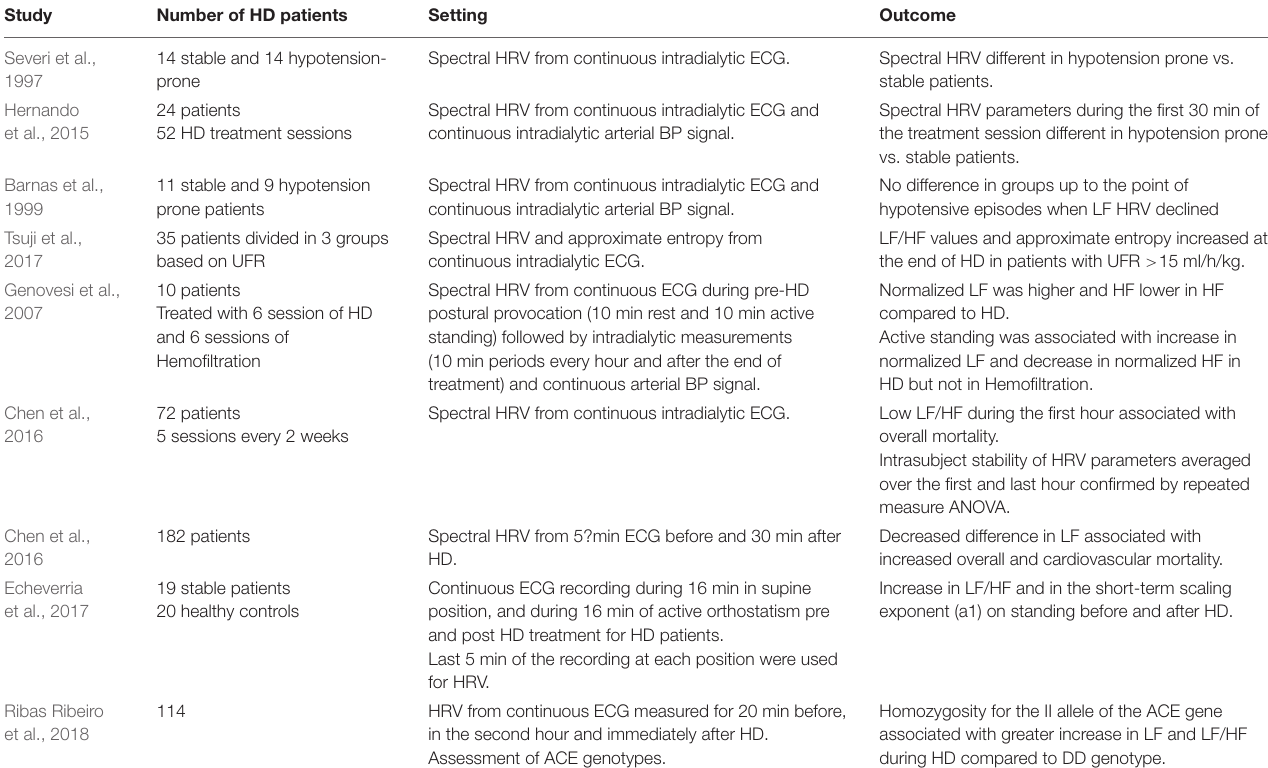
TABLE 5 | Studies using short term Heart Rate Variability assessment with autonomic